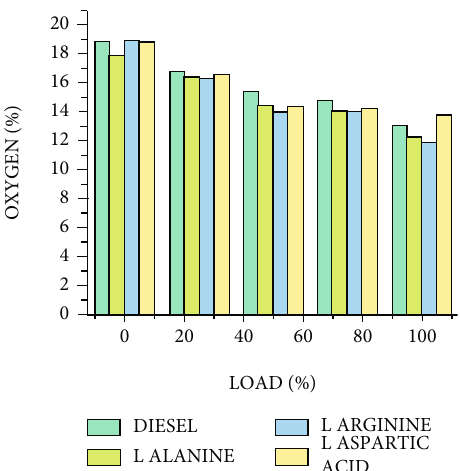
Figure 13: Variation of carbon monoxide with respect to engine